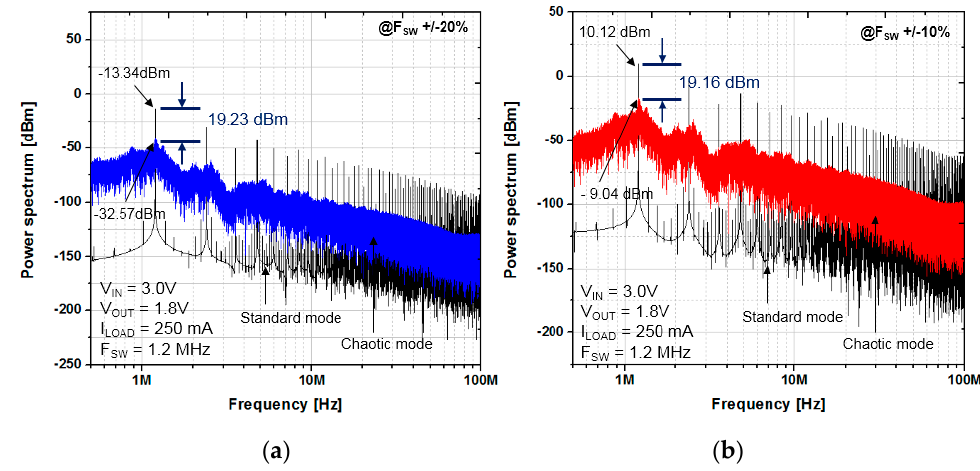
Figure 12. Simulated power spectrum in chaotic mode (with slope modulation) with F SW +/ − 20% (0.96 MHz to 1.44 MHz): ( a ) Output node; ( b ) Switching node (@V DD = 3.0 V, Vo = 1.8 V, Io = 500 mA, L = 2.2 µH, C = 2.2 µH).